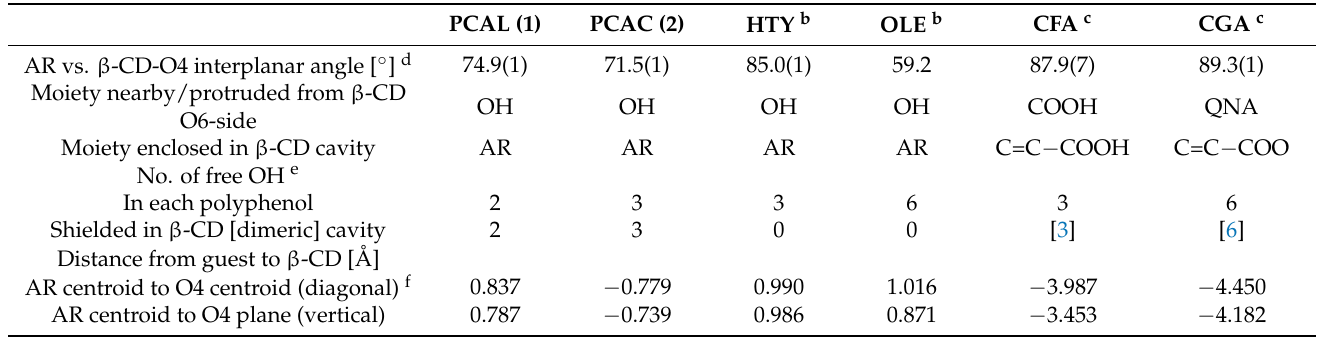
Table 1. Inclusion Structures of PCAL ( 1 ), PCAC ( 2 ) Encapsulated in the β -CD Cavity, in Comparison to Other 1:1 β -CD–3,4-Dihydroxybenzene Complexes a .